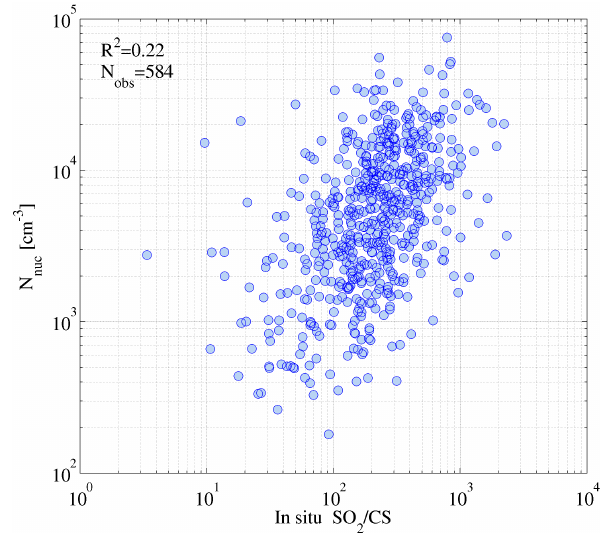
Figure 9. Correlation between nucleation mode number concentra- tion and SO 2 /CS proxy calculated using in situ data at Marikana measurement station at the time of the satellite overpass (13:00– 14:00LT).